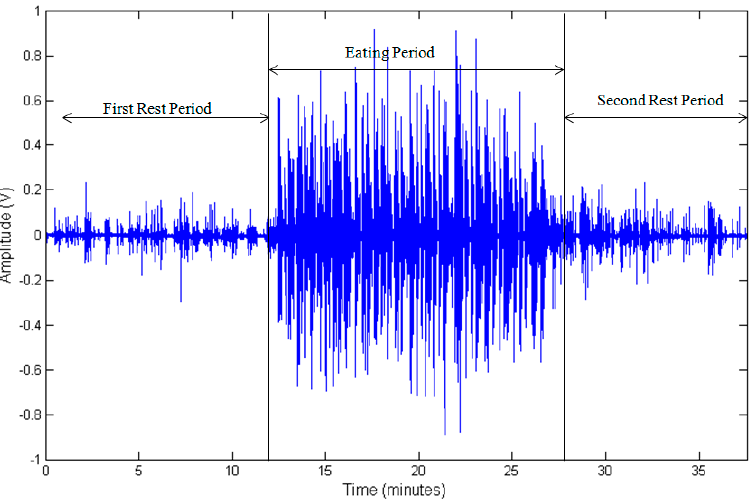
Figure 2. Piezoelectric sensor (raw) signal shows three parts of the experiment. First is a rest period, followed by an eating episode which is followed by a second rest period. Sampling frequency used was 44,100 Hz.